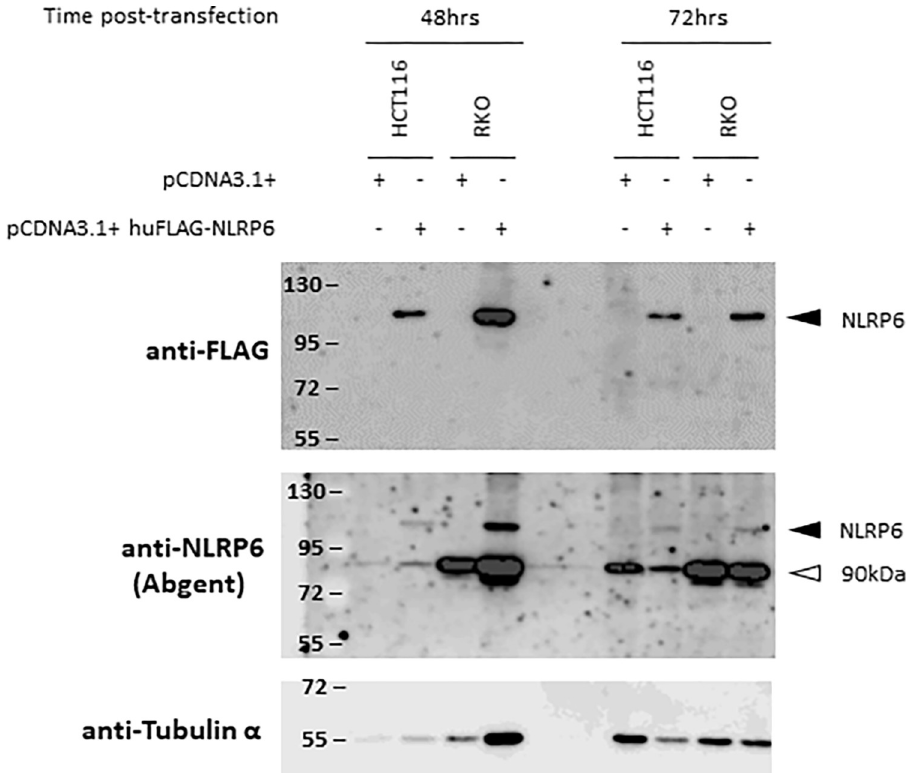
Fig 1. The endogenous NLRP6 expression is not detected in HCT116 and RKO cancer cell lines by western- blotting using an antibody from ABGENT. Western-blot analysis of extracts of HCT116 and RKO cells made 48 or 72hrs after transfection with a pCDNA3.1+ vector either empty or encoding the human full-length FLAG-NLRP6 protein. The migration position of NLRP6 is indicated with a dark arrowhead. The white arrowhead points a non- specific band at